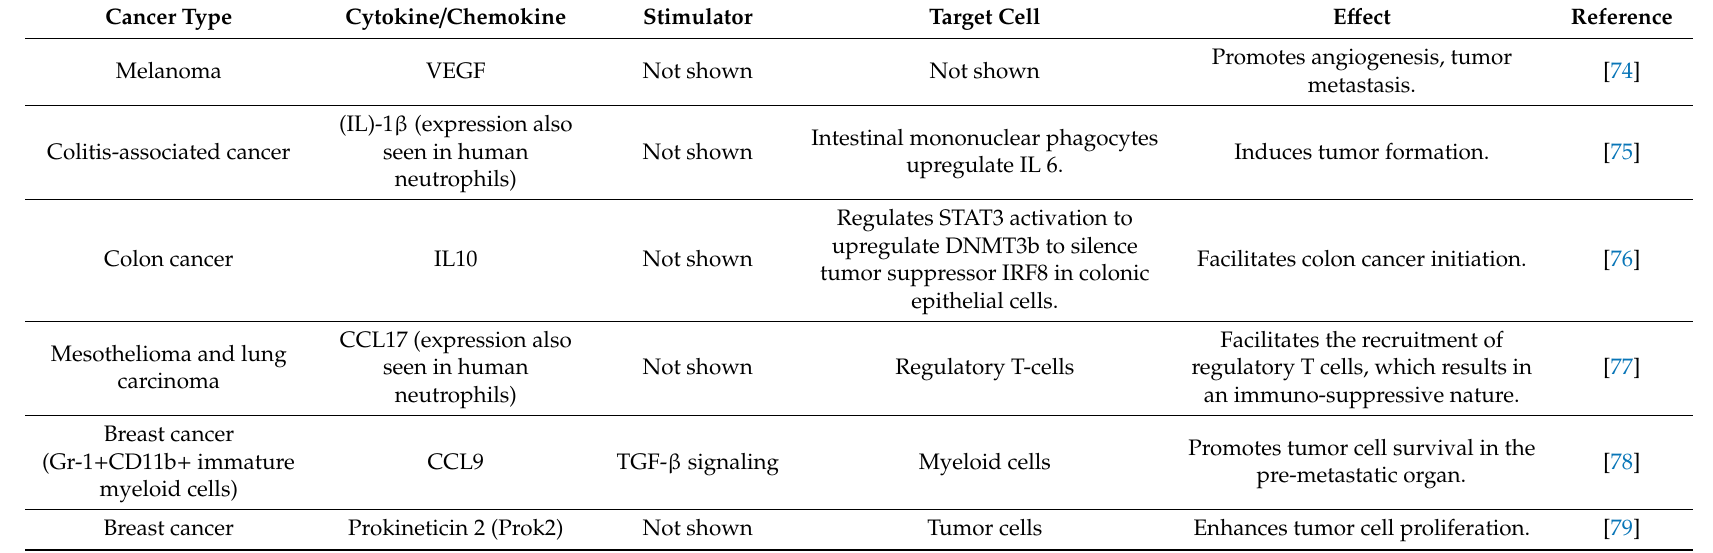
Table 2. Neutrophil produced cytokines and chemokines in the mouse